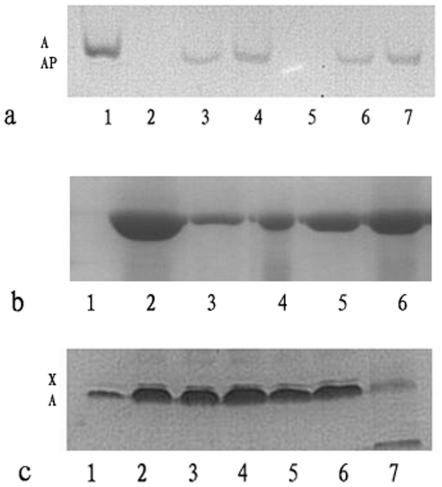
Electrophoretic analysis of the interaction of actin with BmTHY.a,Effect of BmTHY and Tβ4 on the mobility of actin in nondenaturing polyacrylamide gel. NPAGE of muscle G-actin plus BmTHY or Tβ4 shows that both BmTHY and Tβ4 shift the mobility of actin in a stoichiometric fashion. Lane 1,2 µg of G-actin ; Lane2 and 5,blank; Lane 3, 0.6 µg of Tβ4 and 2 µg of G-actin ; Lane 4, 1.2 µg of Tβ4 and 2 µg of G-actin ; Lane 6, 0.6 µg of BmTHY and 2 µg of G-actin ; Lane 7, 1.2 µg of BmTHY and 2 µg of G-actin. b,sedimentation analysis of the effect of BmTHY and Tβ4 on salt-induced actin polymerization. 100 µL of G-actin was mixed with:100 µL of G-buffer (lane 1); 100 µL of KCl-buffer (lane 2); 66 µL of Tβ4 (lane 3); 66 µL of BmTHY (lane 4);33 µL of Tβ4 (lane 5); 33 µL of BmTHY (lane 6);The molar ratio of BmTHY (Tβ4) to actin was 0.57∶1 in lanes 3 and 4 and 0.28∶1 in lanes 5 and 6. The final actin concentration was 5.8 µM in each assay. Each pellet was solubilized in 50 µL of SDS sample buffer. c,cross-linking of BmTHY and Tβ4 to G-actin. G-actin was incubated with either BmTHY (lane 2, 3 and 4) or Tβ4 (lane 5 and 6) plus 1-ethyl-3-(3-dimethylaminopropyl) carbodimide for 2 h at 25°C. The molar ratio of BmTHY (Tβ4) to actin was 1∶5 in lanes 2, 3 and 5 and 1∶9 in lanes 4 and 6. Lane 1 was G-actin. Lane 7 was protein molecular weight marker. Each aliquots were taken up into SDS sample buffer and analyzed by SDS-PAGE on a 10% gel under reducing conditions.